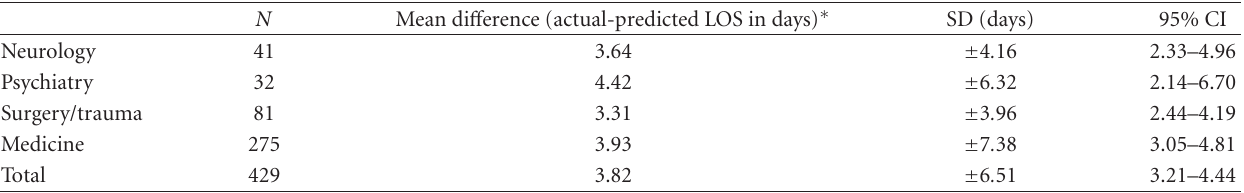
Table 2: Predicted and actual LOS within admitting